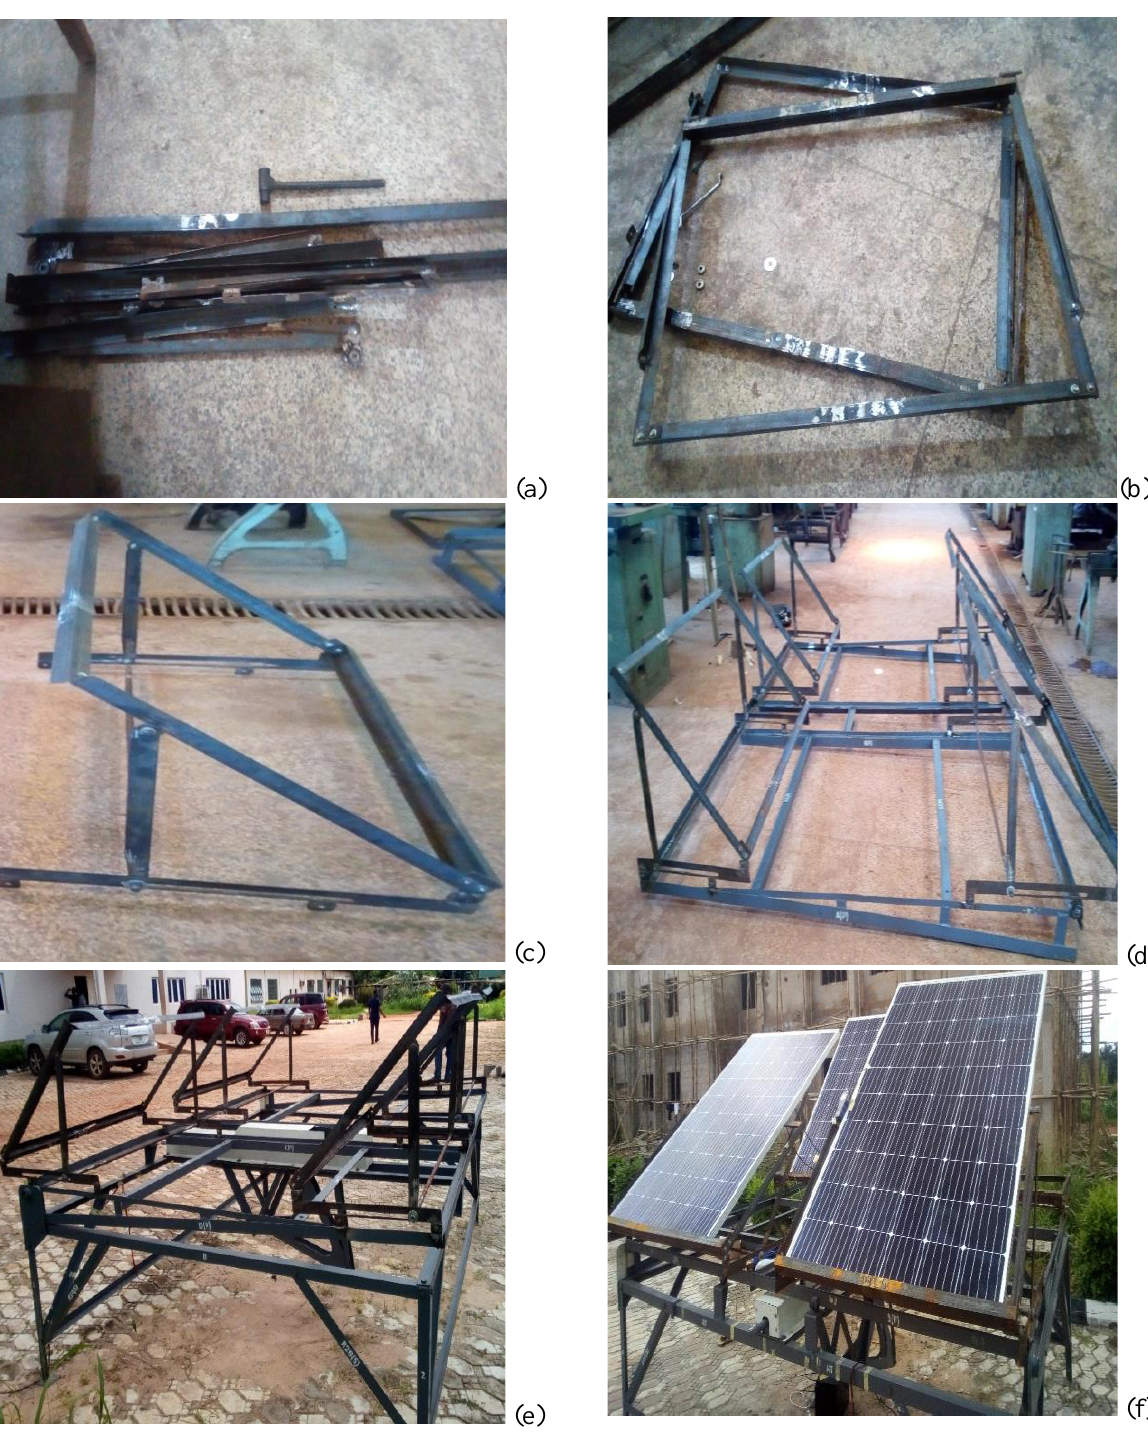
Figure 12. (a-f) The fully fabricated solar photovoltaic tilting platform